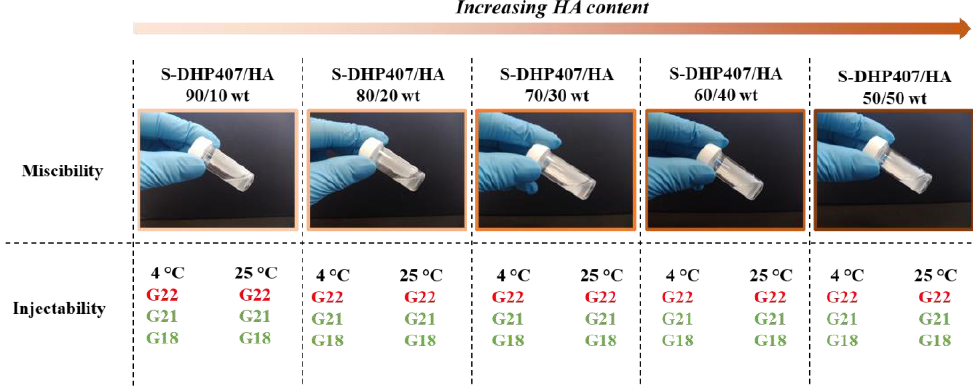
Figure 6. Representative photos of S-DHP407/HA formulations with increasing HA content from left to right (overall polymeric concentration 15% w / v ) proving the successful miscibility of the synthetic and natural polymers at the macroscale. Injectability assessment at two temperatures (i.e., 4 °C and 25 °C) through G18, G21 and G22 needles. Green and red stand for assessed and unassessed injectability, respectively.